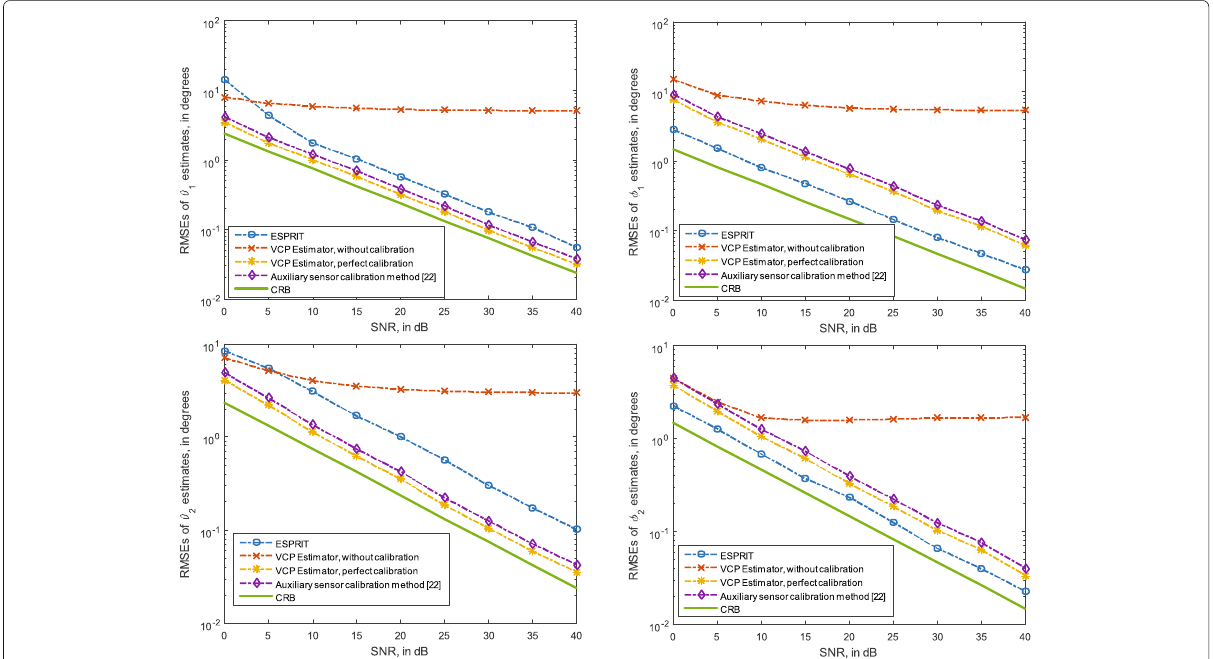
Fig. 4 RMSEs of angle estimates against SNR. Two uncorrelated signals with θ 1 = 21.13°, φ 1 = 33.69° and θ 2 = 39.82°, φ 2 = 51.34° impinge upon a single-vector sensor. Five hundred independent experiments are conducted